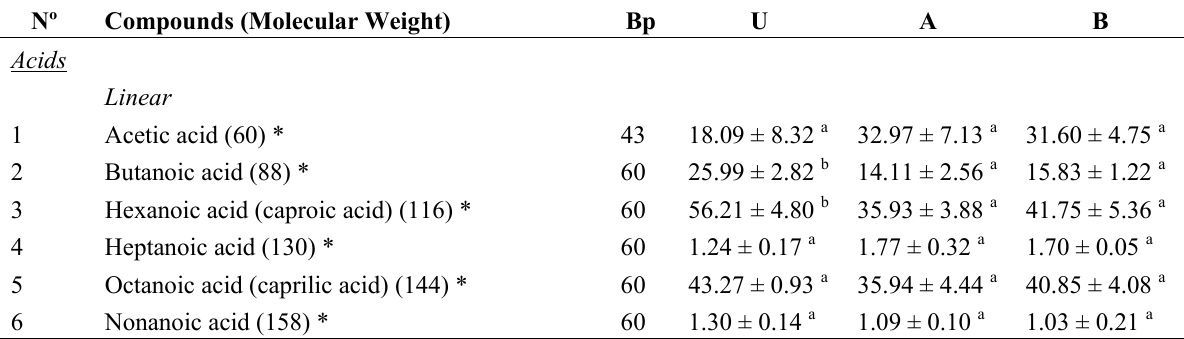
Table 1. Acids, alcohols, esters and lactones detected in the headspace of the exterior region of unsmoked (U) and smoked (A and B) Herreño cheeses studied, together with their molecular weight, the base peak of their mass spectra (Bp), their abundance, expressed as average area counts of their mass spectra base peak divided by 10 5 , and standard deviation a